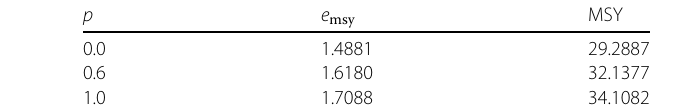
Table 9 The values of the maximum sustainable yield (MSY) and maximum effort ( e msy ) for different values of the parameter p when only prey species is harvested p e msy